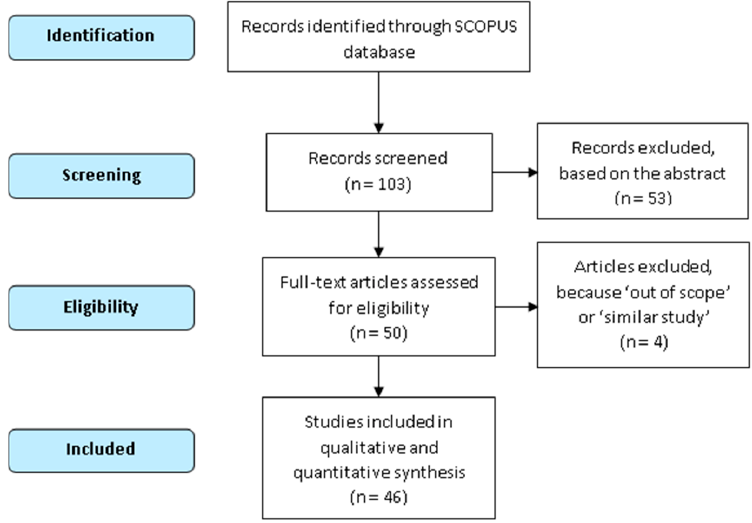
Figure 1. PRISMA-based flowchart of the systematic selection of the relevant studies.